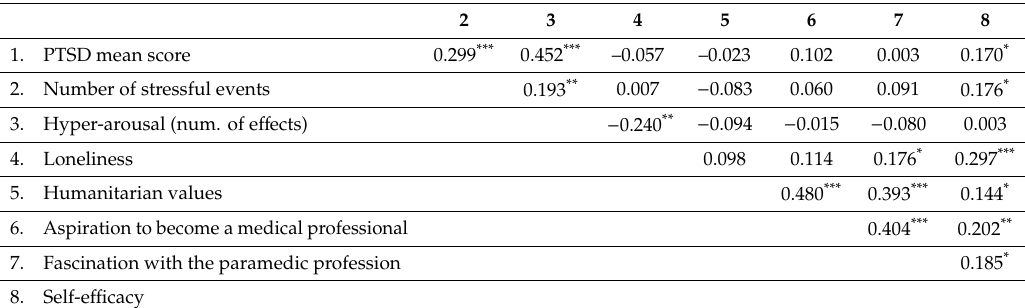
Table 4. Spearman correlations of PTSD, motivational, and dispositional factors among MDA youth volunteers (N = 236 +